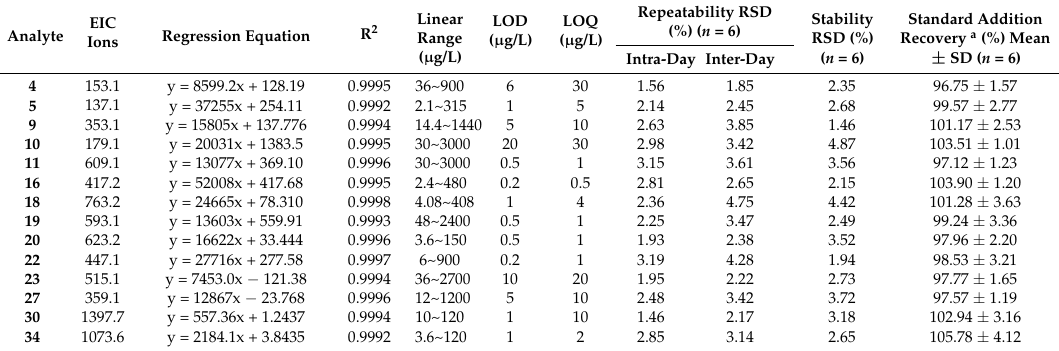
Table 2. Linear-regression data, LODs, LOQs and recovery of the 14 constituents determined by